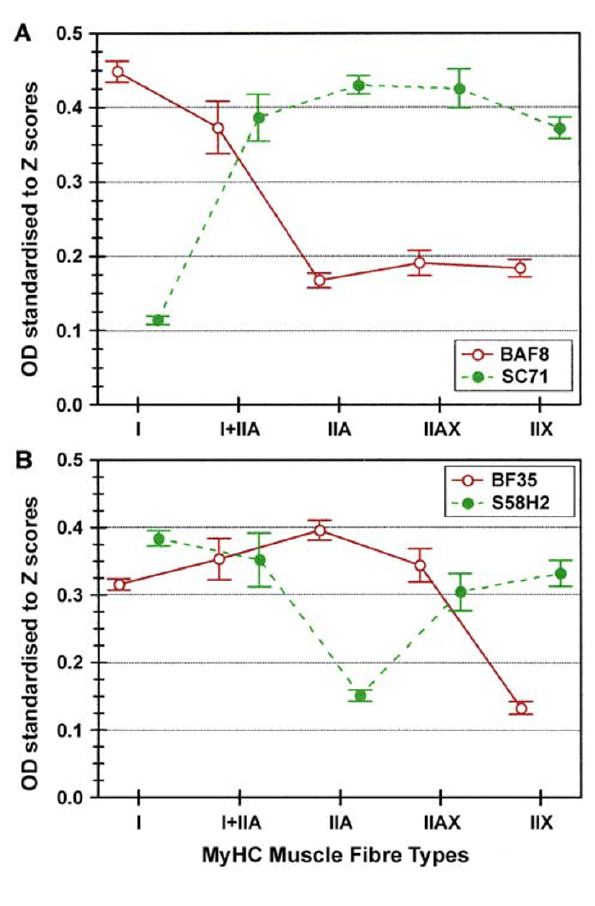
Table 2: Different fibre types in each of the two studied